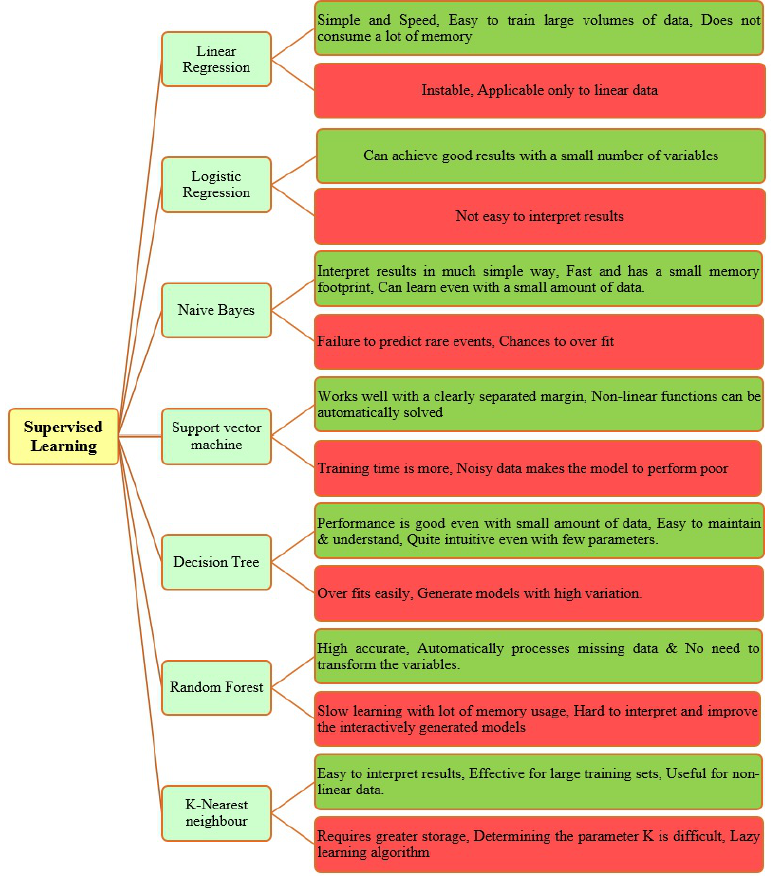
Figure 10. Pros. (Light Green) and Convs. (Light Red) of Supervised learning models